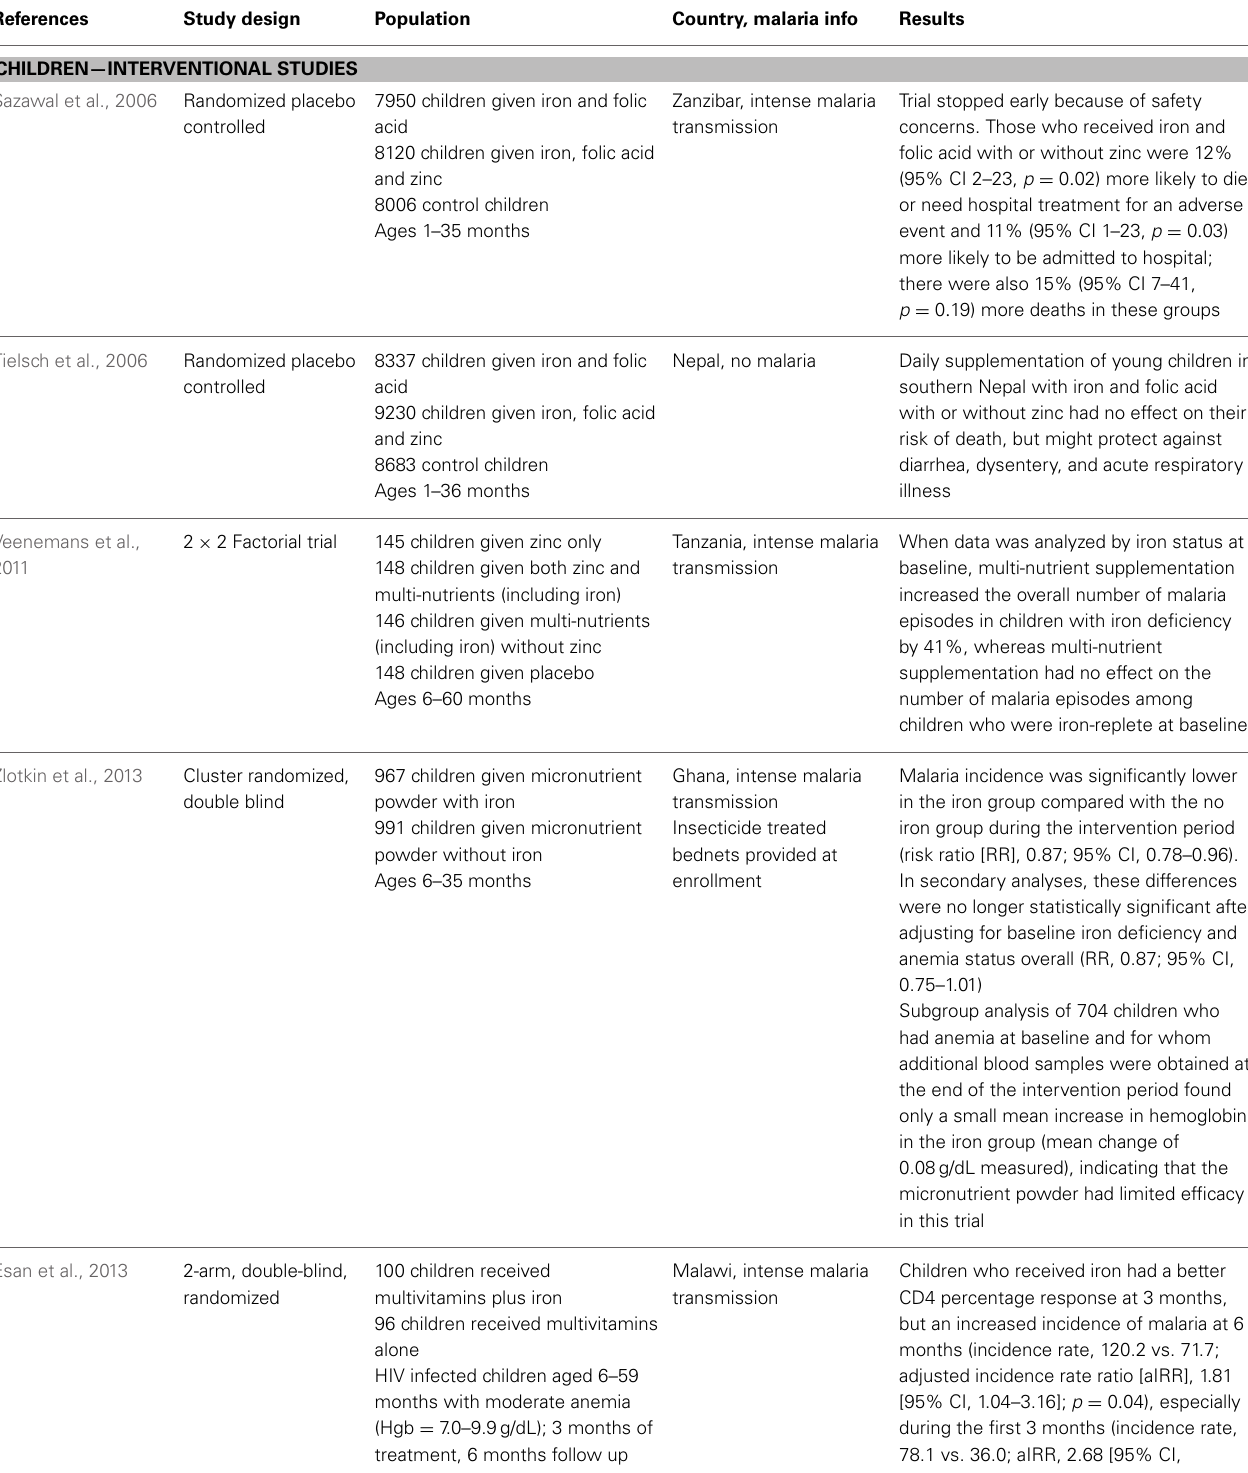
Table 1 | Summary of clinical studies on iron deficiency, iron supplementation, and